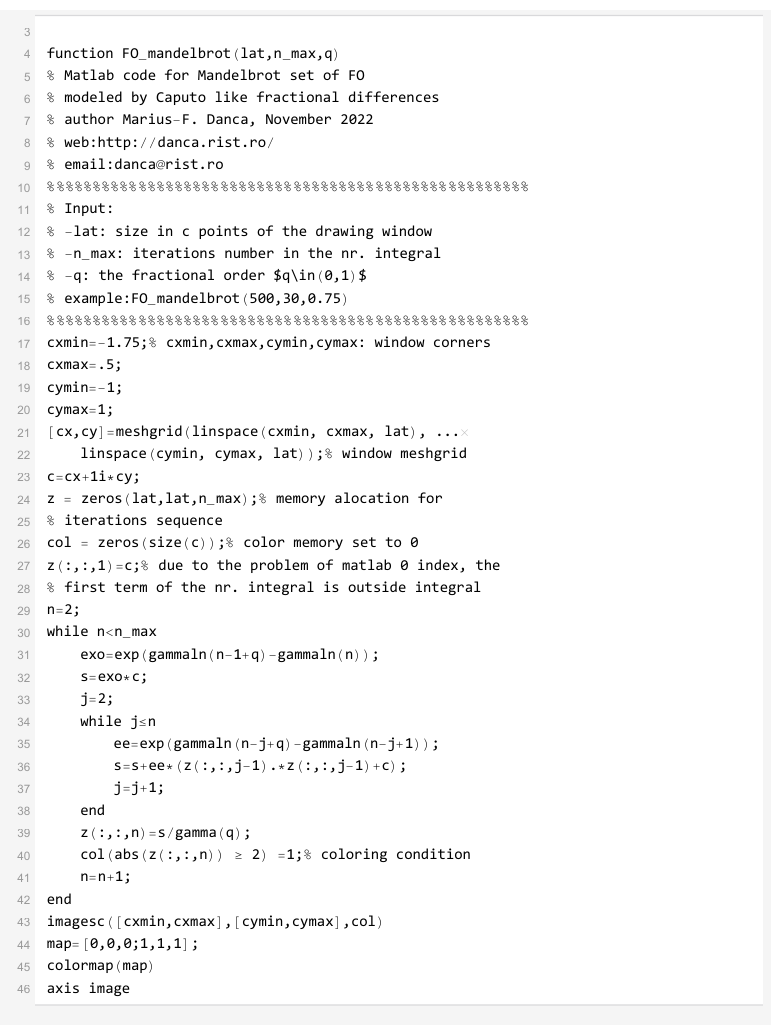
Figure A1. The code is set to draw the FOM set in B-W, and it can be improved such that the speed is increased and colors are enhanced. To obtain the enlarged versions of some parts of the FOM set, the underlying corners must be modified (see https://www.mathworks.com/matlabcentral/